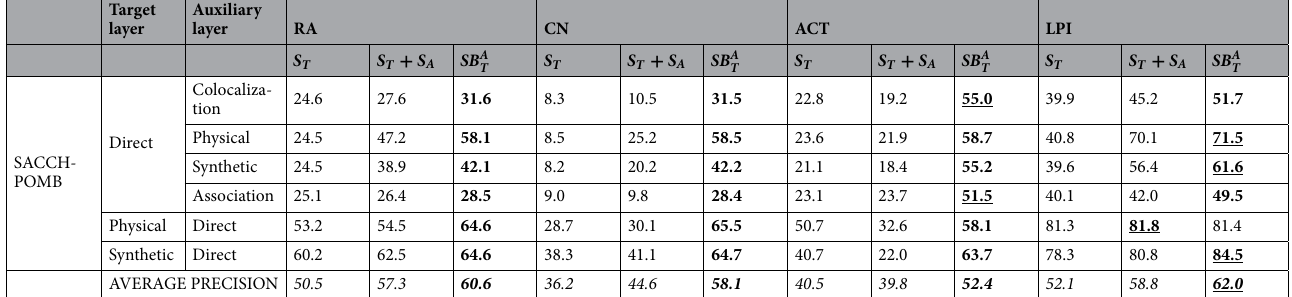
Table 3. Average Precision over 100 iterations for the networks under study. Each row shows the performance of link prediction methods on a duplex of a multiplex network grouped by the corresponding base similarity measure in use. Columns show the average Precision over 100 iterations for the prediction methods S T (similarity score of only the target layer), S T + S A (addition of similarity scores of the target and auxiliary A T , A layer), SB T ≡ SB